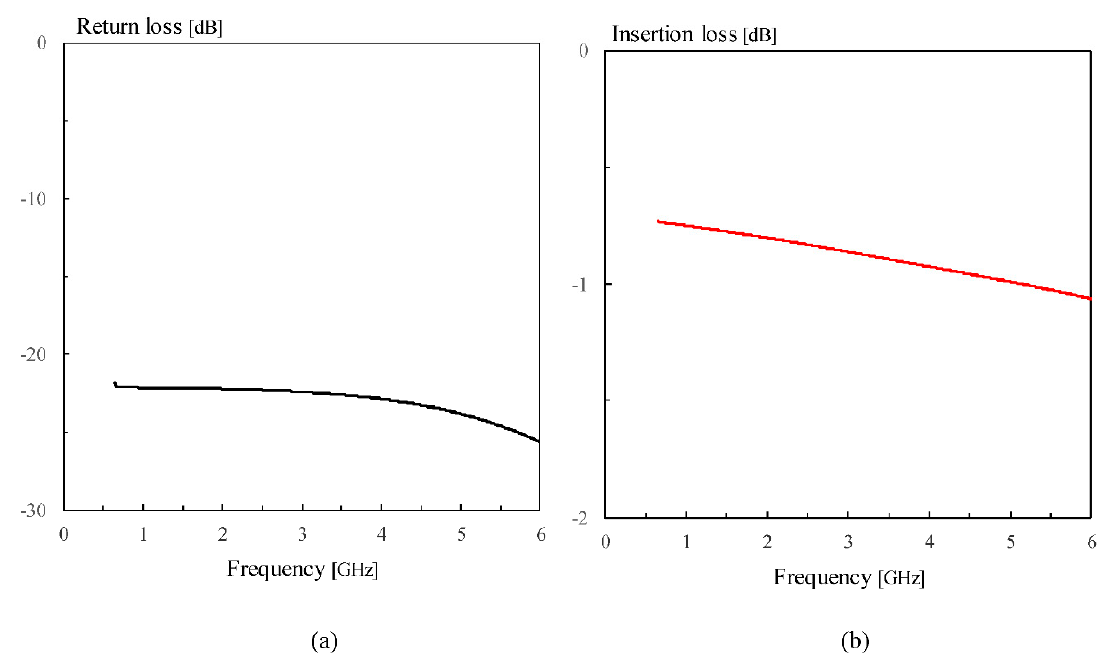
Figure 4. S-parameters recorded in the frequency range from 60 MHz to 6 GHz. ( ® Ansys/HFSS—S11—